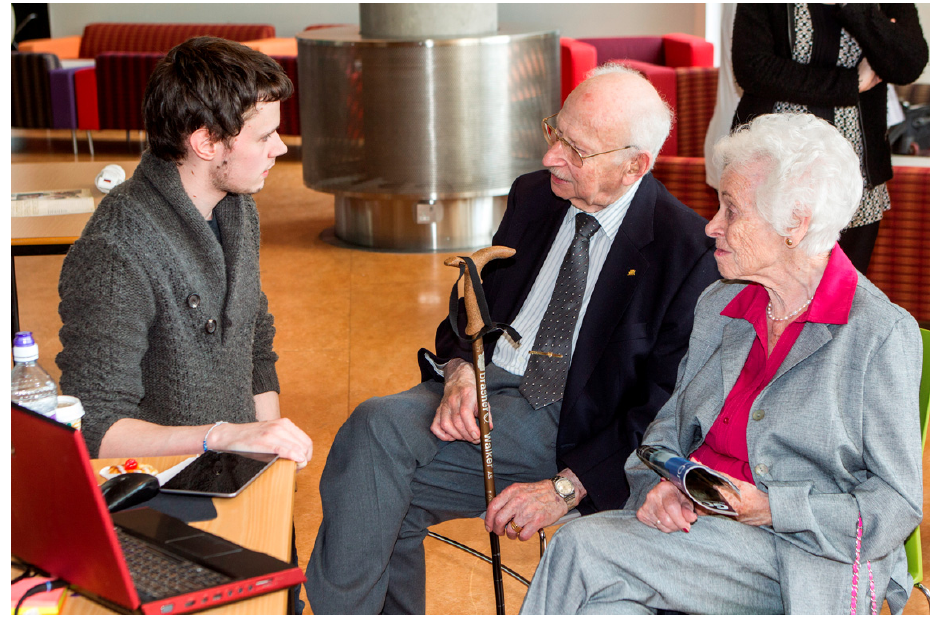
Figure 6. Students and refugees at the game jam at Glasgow Caledonian University in August,